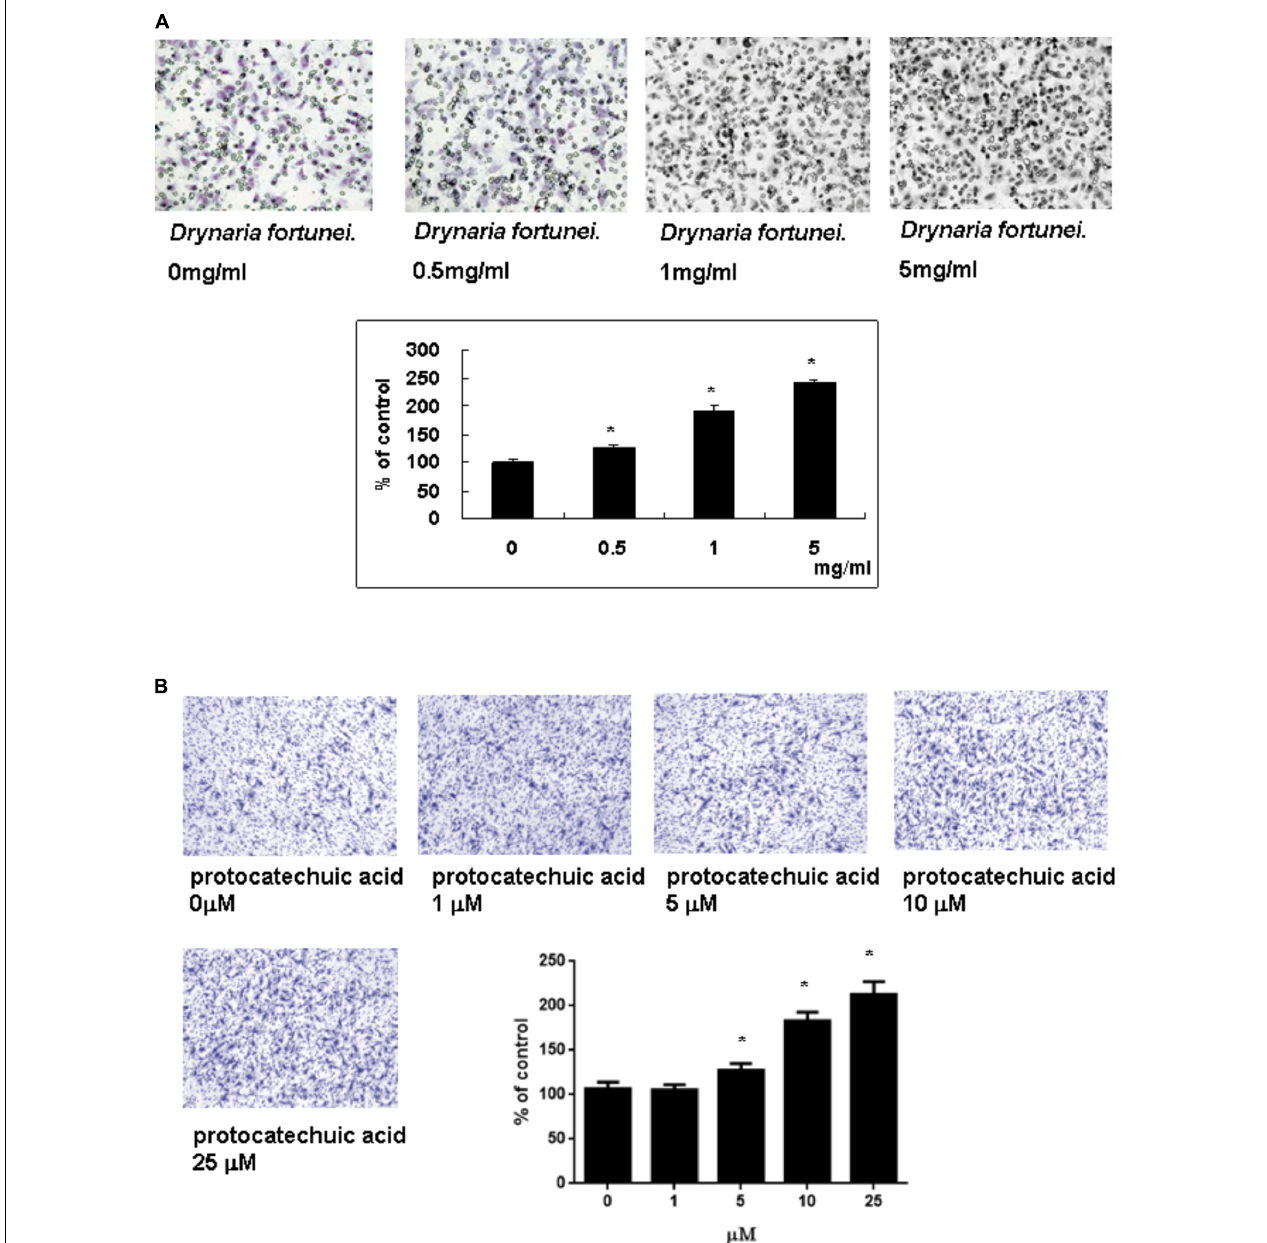
FIGURE 4 | The D. fortunei and PA increased the migration ability of HUVECs. A Transwell chamber was used for the migration assay. HUVECs were treated with different concentrations of D. fortunei and PA for 24 h. The cells that migrated onto the lower surface of the filter were examined by microscope (magnification, × 100). Both of D. fortunei (A) and PA (B) stimulated the migration of HUVECs through the uncoated porous filter for 2 h with a dose-dependent manner paralleled with increasing concentrations. Data were mean ± SD calculated from three individual experiments. An asterisk demonstrated the significant difference ( ∗ P < 0.05) compared with